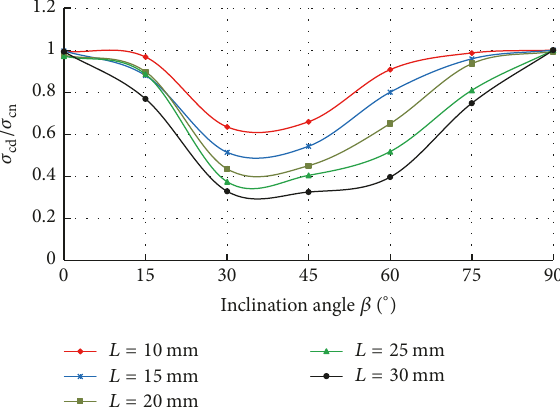
Figure 12: 𝜎 cd /𝜎 cn versus flaw inclination angle 𝛽 under different flaw length 𝐿